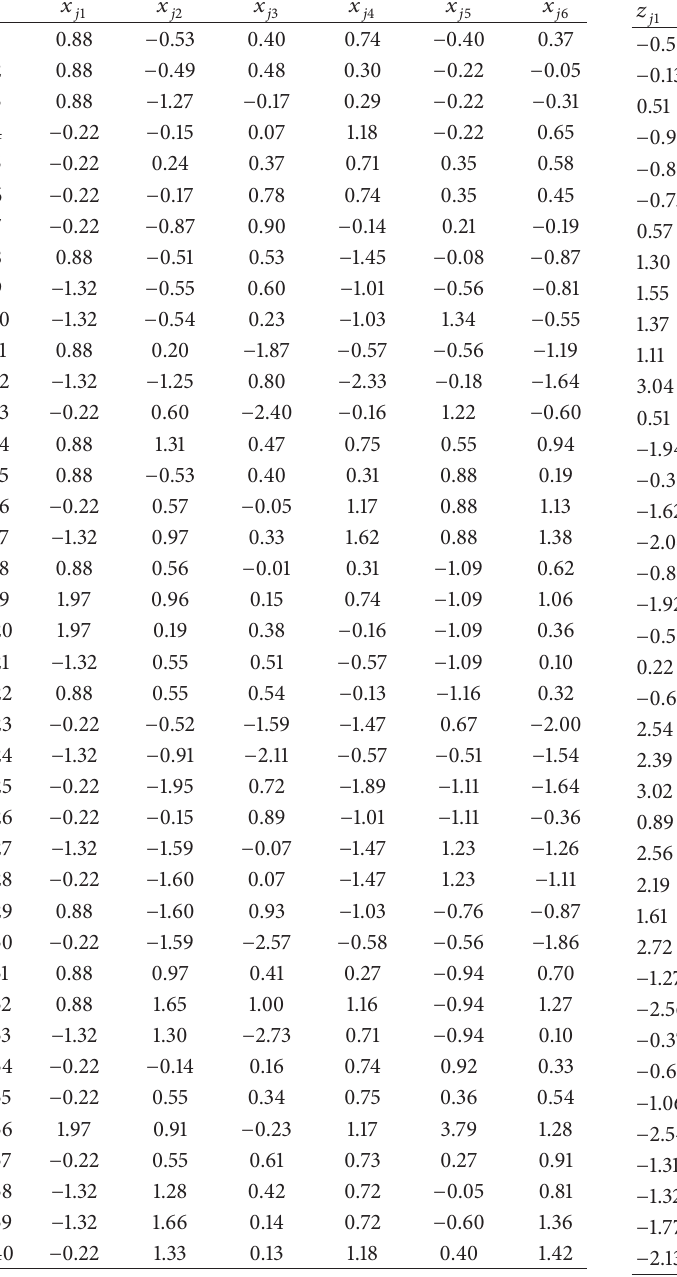
Table 3: The standardized data. Table 4: New inputs to the